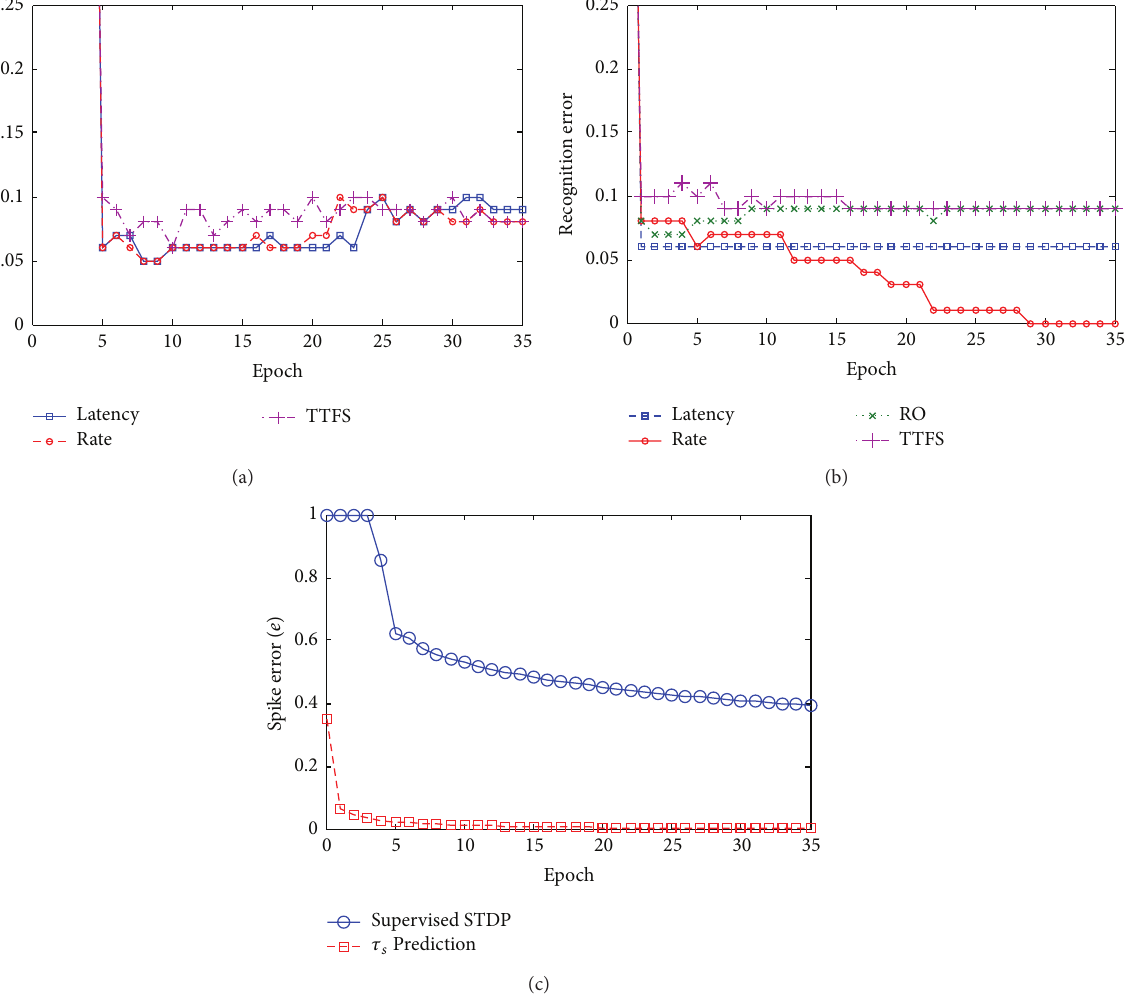
Figure 11: Convergence analysis on (a) Supervised STDP and (b) 𝜏 𝑠 Prediction using different spike codings (c) shows the comparison on spike error 𝑒 of Supervised STDP and the 𝜏 𝑠 Prediction learning methods as the training iteration grows. The errors are taken as average of recognition error from AR Scream S1 and Scarf S1. The recognition error at 𝑒 > 0.25 in (a) and (b) is not shown for clarity of the graph. For = 1 for all tested is not shown since 𝑒 Supervised STDP, recognition error for RO coding 𝑒 RO RO